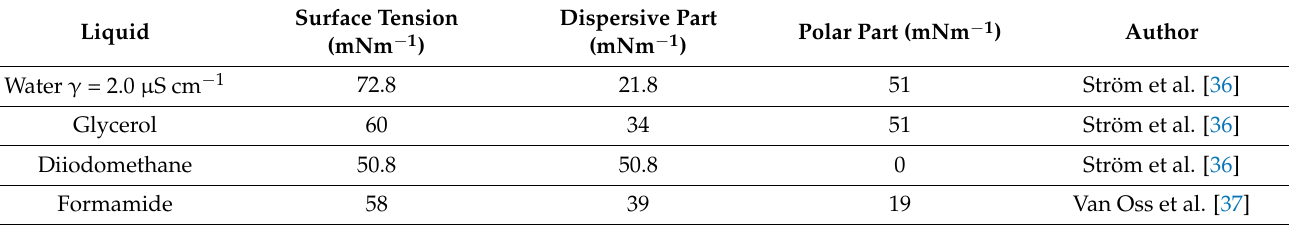
Table 2. Liquids for surface free energy calculation and their